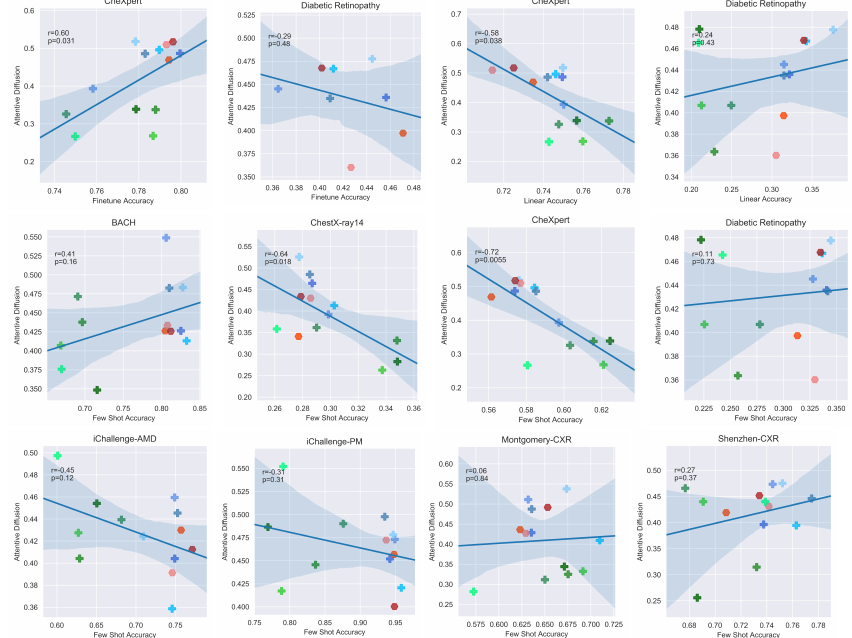
Figure A2. Attentive diffusion values for the reconstructed images plotted against transfer perfor- mance. Shown overlaid are the Pearson’s r correlation coefficients and associated p values.